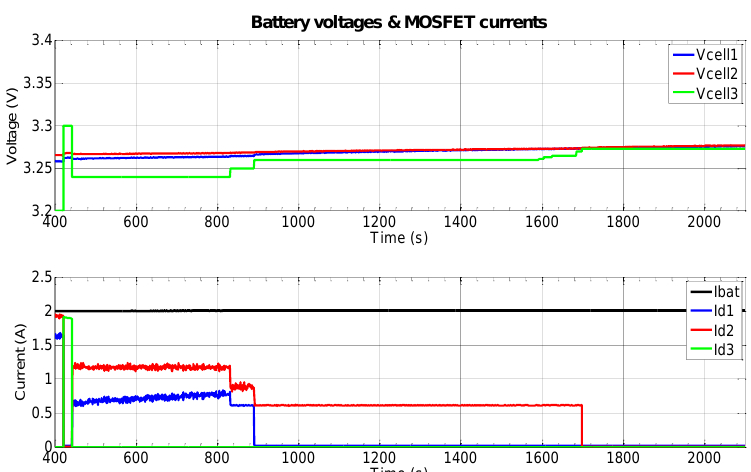
Fig. 9. Charging mode. Upper subplot, from top to bottom, instant Cell 1 , Cell 2 and Cell 3 voltages, respectively. Lower subplot, from top to bottom, instant Cell 1 , Cell 2 and Cell 3 corresponding MOSFETs currents,